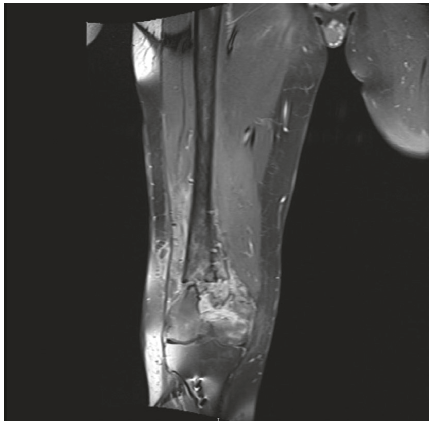
Figure 1: MRI of the the right knee and femur showing that the bone tissue is heavily disrupted with several infectious lytic foci in the diaphyseal and metaphyseal portion, swelling of the cancellous bone, and periosteal reaction. A cutaneous fistula draining from a fluid collection in the vastus lateralis muscle can be